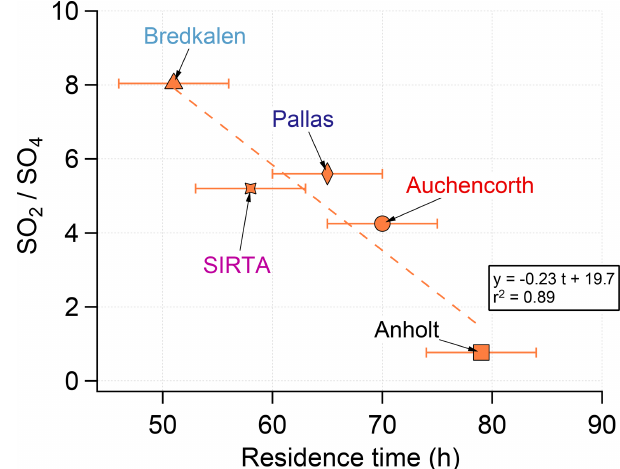
Figure 16. Scatter plot of the SO 2 : SO 4 mass concentration ratio (in PM 1 fraction for ACSM data at SIRTA, PM 10 for EMEP sta- tions) with the residence time or plume age (in h) of the volcanic cloud at a selection of stations in five different countries of northern Europe displayed in Fig.